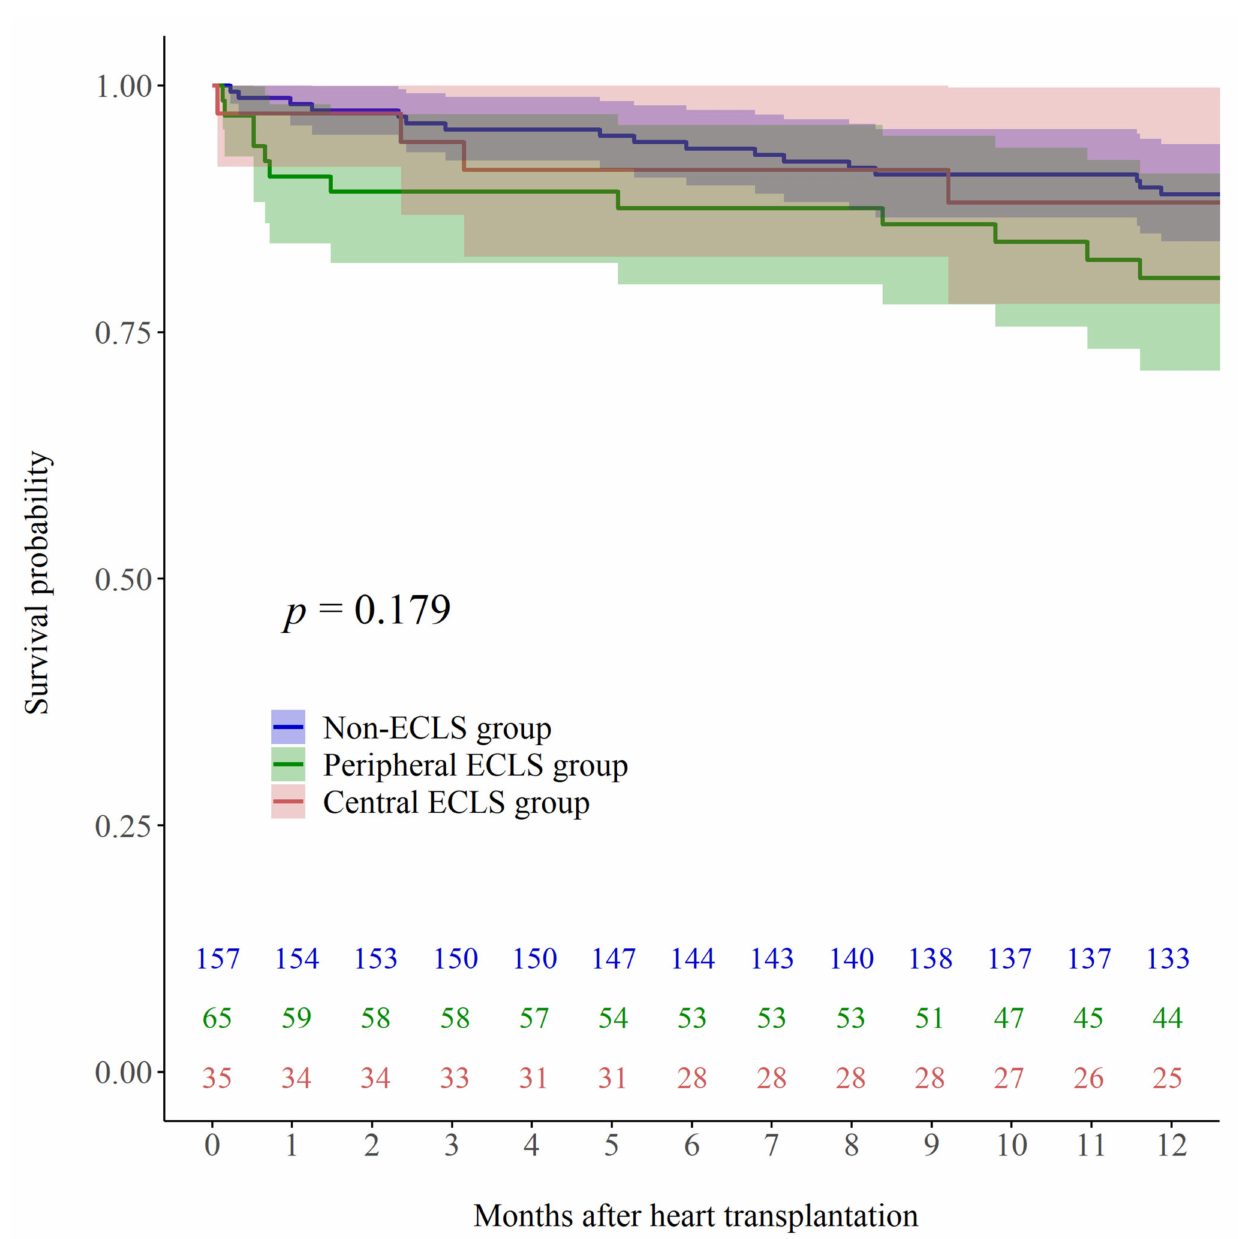
Figure A1. Kaplan–Meier post-HTx survival curves for patients who were supported by peripheral ECLS while waiting for HTx (Peripheral ECLS; green line), those who had central ECLS at the time of HTx (Central ECLS; red line), and those who did not receive ECLS before HTx (Non-ECLS; blue